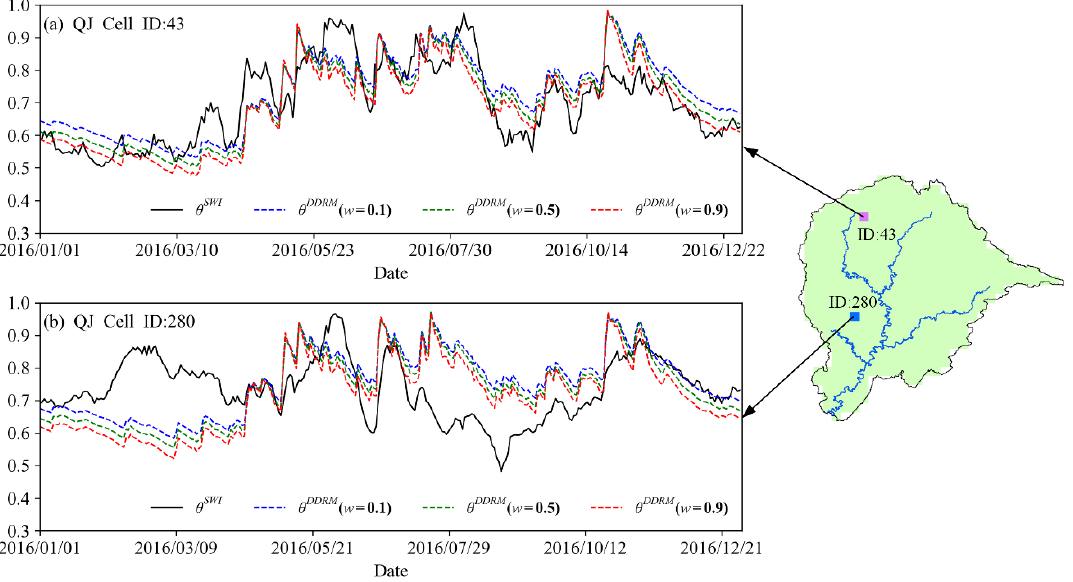
Figure 9. Temporal comparison of cell-based SWI series ( 𝜃 𝑖𝑆𝑊𝐼 ) and DDRM-simulated soil moisture series ( 𝜃 𝑖𝐷𝐷𝑅𝑀 ) for QJ. Two cells ( a ) cell ID 43 and ( b ) cell ID 280 are shown here for illustration purposes.